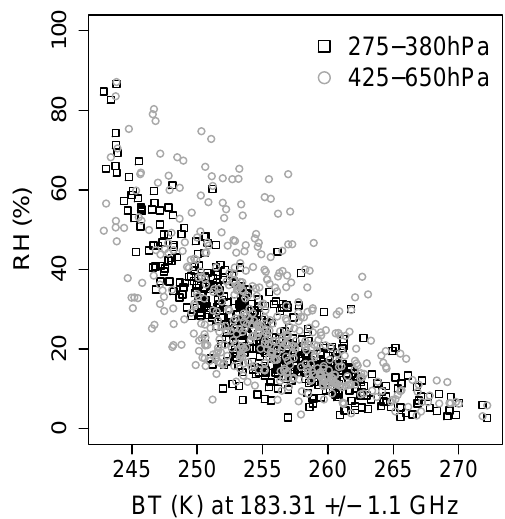
Figure 2. Relationship between the RH of two atmospheric layers (in %RH) and the associated BT (in K) at 183 . 31 ± 1 . 1GHz (2nd channel of SAPHIR). The RH of the 275–380hPa layer is repre- sented with black squares, while the gray circles are for the RH of the 425–650hPa